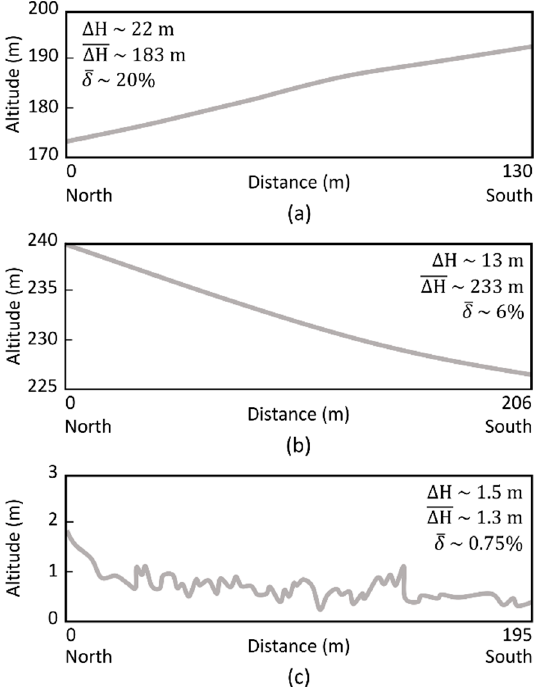
Figure 17. Elevation profile lines of the scanned areas: ( a ) Vallado; ( b ) Lousada and; ( c ) Viana. ∆ H represents the altitude difference, ∆ H represents the terrain average altitude, and δ represents the terrain average slope.